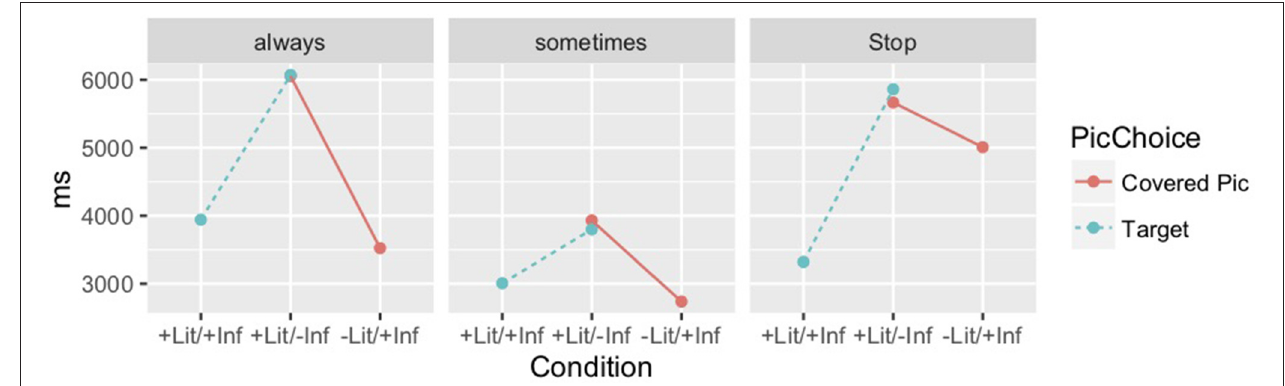
FIGURE 7 | RTs for responses by picture choice and inference status for stop data. RTs for always and sometimes from Experiment Ia repeated for comparison. + Lit/ + Inf target choices and + Lit/ − Inf Covered picture choices are taken to reflect inference interpretations, and + Lit/ − Inf target choices and − Lit/ + Inf Covered picture choices no-inference